Question: According to the figure, is the described quantity increasing or decreasing?
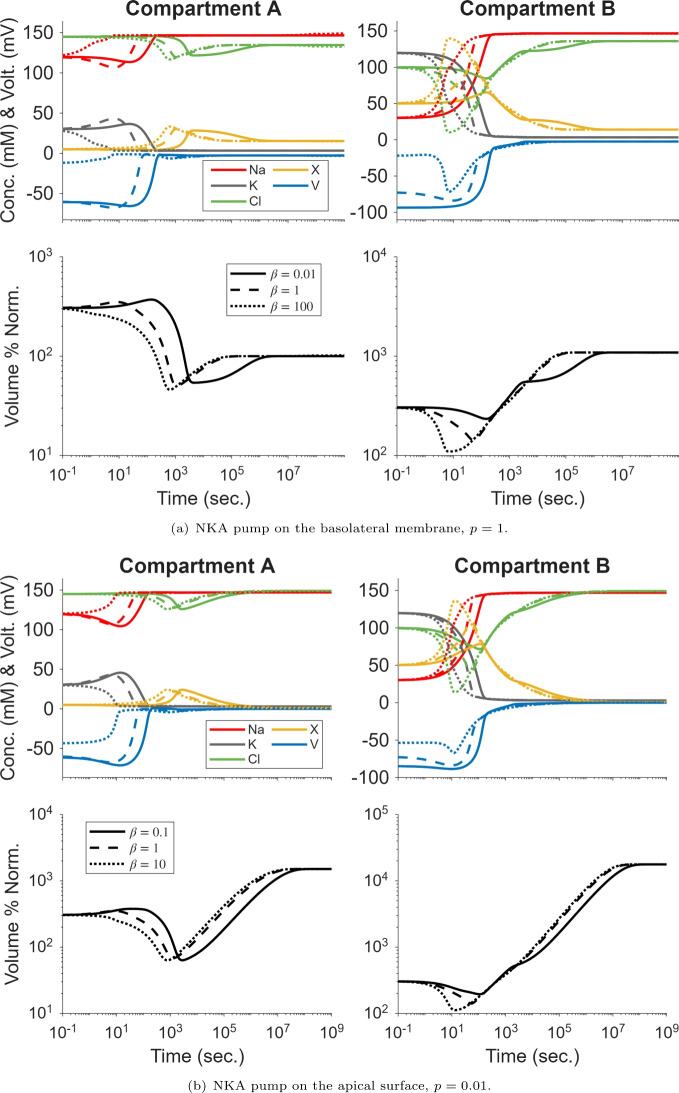
Answer: increasing